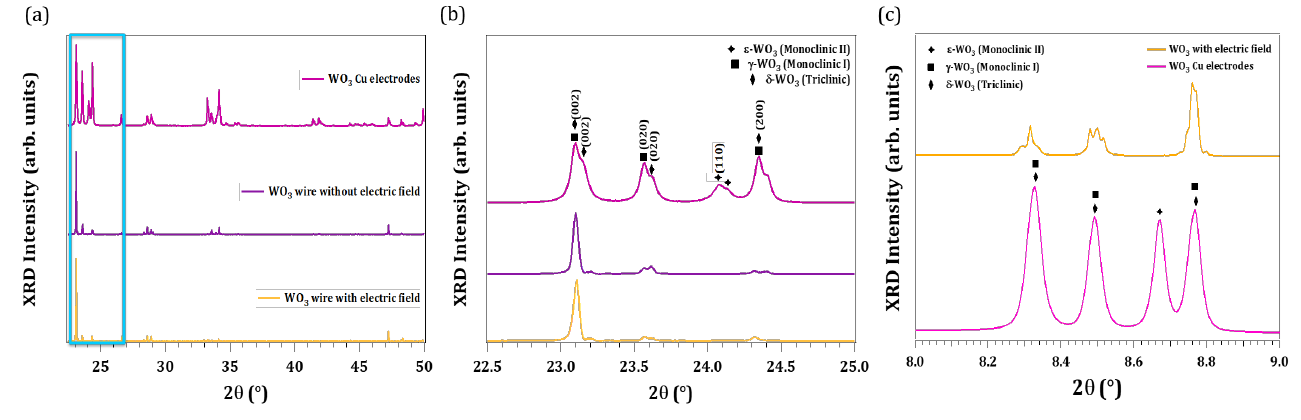
Figure 3. XRD results. ( a ) XRD data from three representative samples. Formed on W wire with electric field application (yellow) without field (purple), and on the Cu electrodes (pink). ( b ) Zoom XRD data with peaks assigned to (cid:101) , γ and δ -WO phases. ( c ) Synchrotron radiation XRD. 3 The polymorphous nature of the WO microstructures obtained by resistive heating 3 was also assessed from micro-Raman measurements performed in a confocal